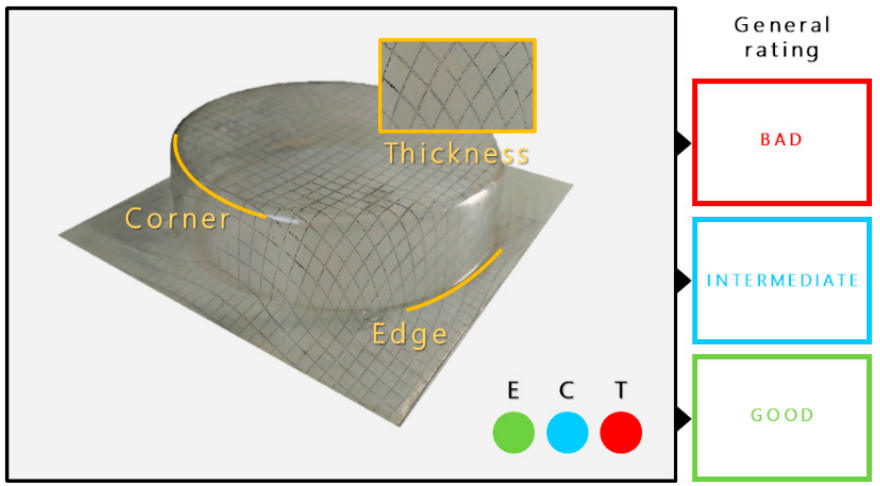
Figure 2. Criteria for the evaluation of thermoformed trays using a positive mold: Linearity of junctions (E), curvature of rounded corner (C), and widening of stamped square net (T). The three parameters lead to a general evaluation for each time shown with the color of the frame.